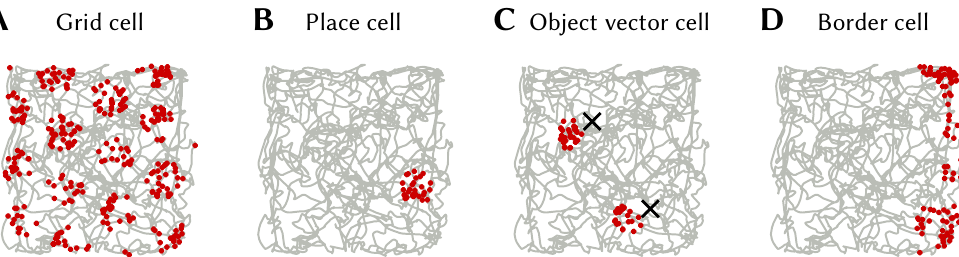
Figure 10. Firing patterns of LIF neurons representing SSPs. ( A ) A grid cell from a population encoding φ ( x ( t )) , where x ( t ) is the path shown in grey (obtained from [58]). Red dots indicate the positions at which the cell fired. ( B ) A place cell from a population encoding φ ( x ( t )) . ( C ) An object vector cell from a population encoding the SSP representation of the vector between x ( t ) and any objects in view. Object locations are marked with an ‘x’. ( D ) A border cell from a population encoding the SSP representation of the vector between x ( t ) and a wall along the right side of the